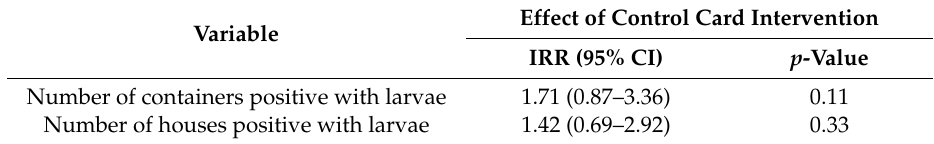
Table 5. Effects of Control Card Intervention to research group (intervention and control